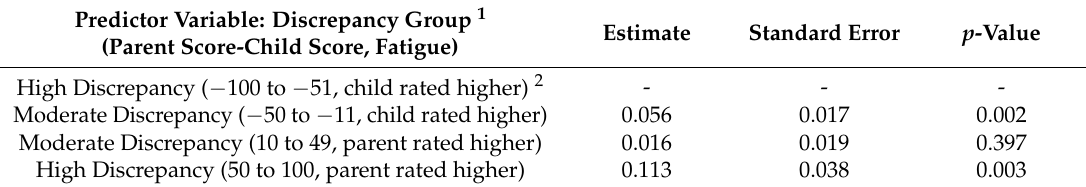
Table 4. Relationship between simple difference of fatigue scores and mean negative mood scores. Predictor Variable: Discrepancy Group